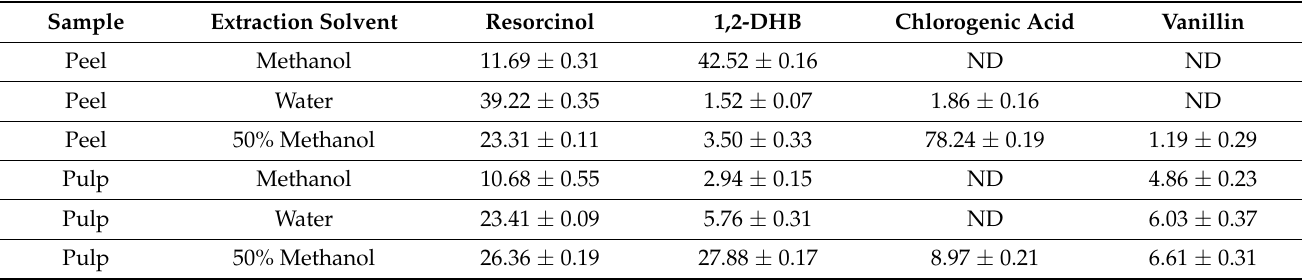
Figure 3. Reducing power of beetroot peel and pulp. The different letters on bars show the significant differences among the extracts for peel and pulp individually ( p < 0.05). Table 3. Analysis of phenolic compounds by HPLC (mg/100 g) dry weight. ND = Not